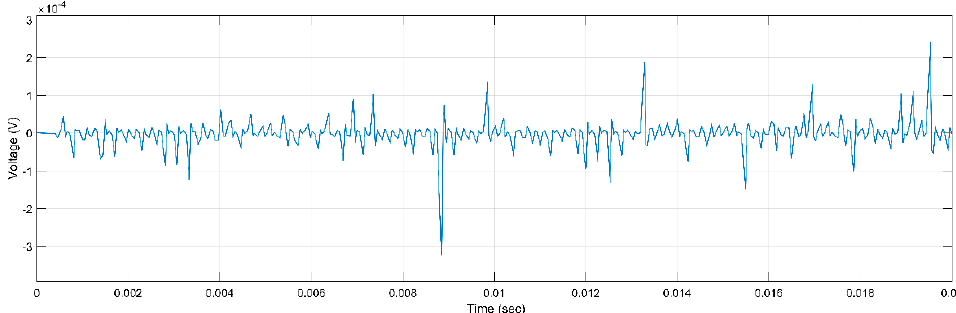
Figure 20. PD Activity for Combination, 10 kV, h, 2 r.